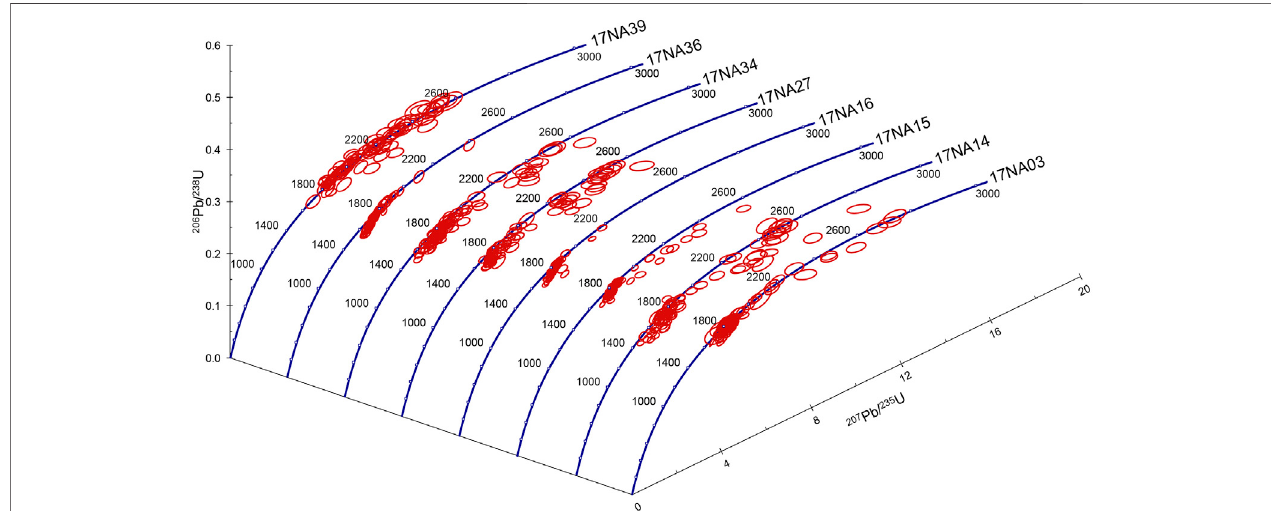
FIGURE6| Wetherillconcordia diagram ofdetrital zircons.Detritalzircons withconcordance > 90%areused inthisstudy.Errorellipses ofdata-pointuse2Sigma.